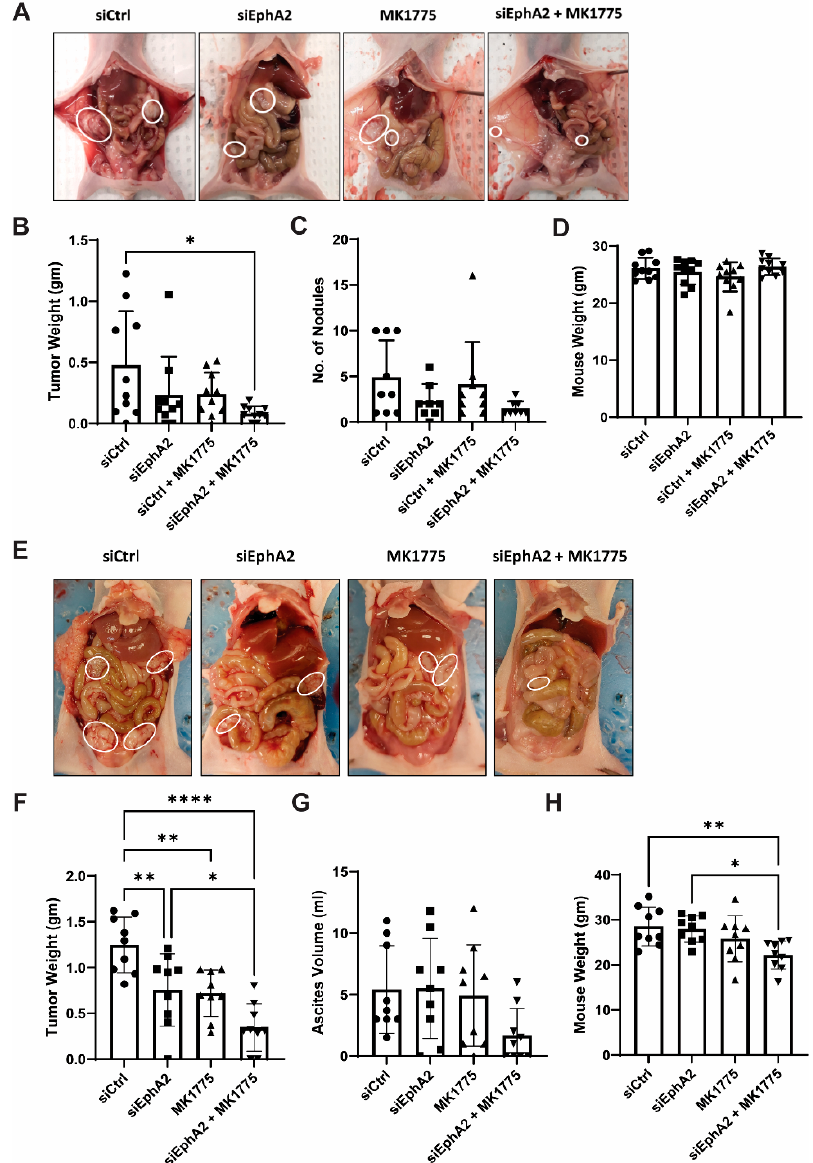
Figure 4. Anti-tumor effects of EphA2- and Wee1-targeted therapy in endometrial cancer xenograft models. Representative images of tumor burden in mice with Hec1A ( A ) and Ishikawa-Luc ( E ) tumors with siRNA nanoparticles and/or MK1775 therapy. ( B , C ) Tumor weights ( B ) and number of nodules ( C ) after therapy in Hec1A model. ( F , G ) Tumor weights ( F ) and ascites ( G ) in Ishikawa-Luc model. Mouse body weights at the end of the experiment in Hec1A ( D ) and Ishikawa-Luc ( H ) models. Statis- tics were performed using one-way ANOVA with the Tukey’s post hoc test for multiple comparisons for more than two groups. * p < 0.05; ** p < 0.01; **** p <